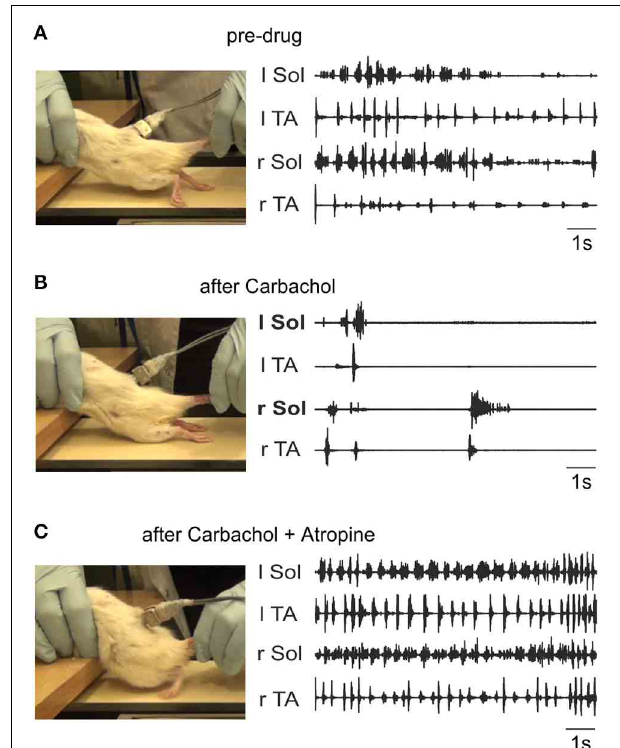
FIGURE 10 | Carbachol disruption of locomotion in spinal rats is reversed by atropine. The left panels show representative frames from the videos taken during the time of the corresponding EMG activity (right panels). (A) Irregular stepping movements produced with tail stimulation prior to drug administration. As shown in the left panel, the EMG activity did not give rise to plantar stepping. The toes were always dragging on the treadmill surface during rhythmic alternating activity. (B) Intrathecal carbachol (1mM, 20 μ l) eliminated all stepping movements immediately, and only a few sporadic episodes of largely synchronous bursting occurred (recording taken 1min after administration). (C) The intrathecal administration of atropine (1mM, 20 μ l) 10min after carbachol treatment restored alternating movement and led to occasional plantar stepping (left panel). The EMG activity was more consistent, and occurred even in the absence of tail stimulation. The recording was made 30min after atropine was